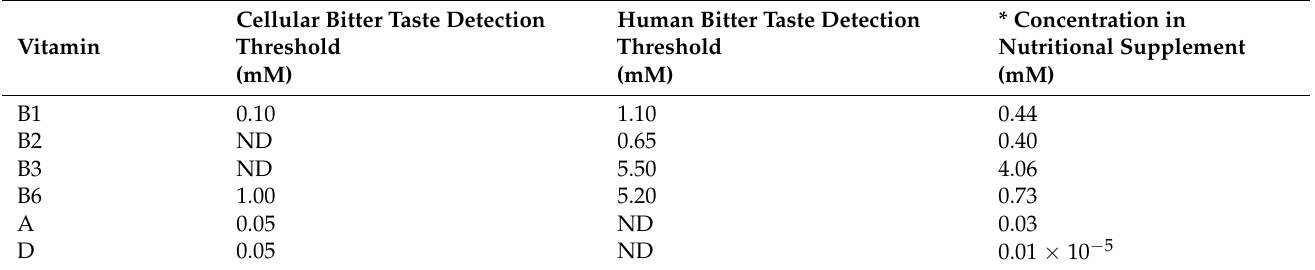
Figure 2. Dose–response curve and EC 50 value measured with cell lines transiently expressing TAS2Rs stimulated with vitamin B6 ( A ), vitamin D ( B ), and vitamin A ( C ). The EC 50 value is defined as the concentration required for half-maximal TAS2R activation. Dose–response curves obtained for HEK293 cells transiently transfected with human TAS2Rs in response to vitamins. HEK293 cells expressing TAS2R7, TAS2R10, TAS2R14, and TAS2R38 were stimulated with vitamins B6, D, and A at a concentration range of 0.003–100 mM. Responses of mock-transfected cells to the same concentration of vitamins are also shown as a negative control. Calcium mobilization using Fluo-4 dye was calculated by baseline subtraction of HEK293T cells from the stable cells and plotted as ∆ F/F. ( A – C ) represent the SEM for three independent experiments performed in triplicate, and error bars represent the standard deviation. EC 50 , half maximal effective concentration; SEM, standard error of the mean; Conc., concentration. Table 3. Comparison between the cellular bitter taste detection threshold, human bitter taste detection threshold, and concentration encountered in nutritional supplements studied for six bitter